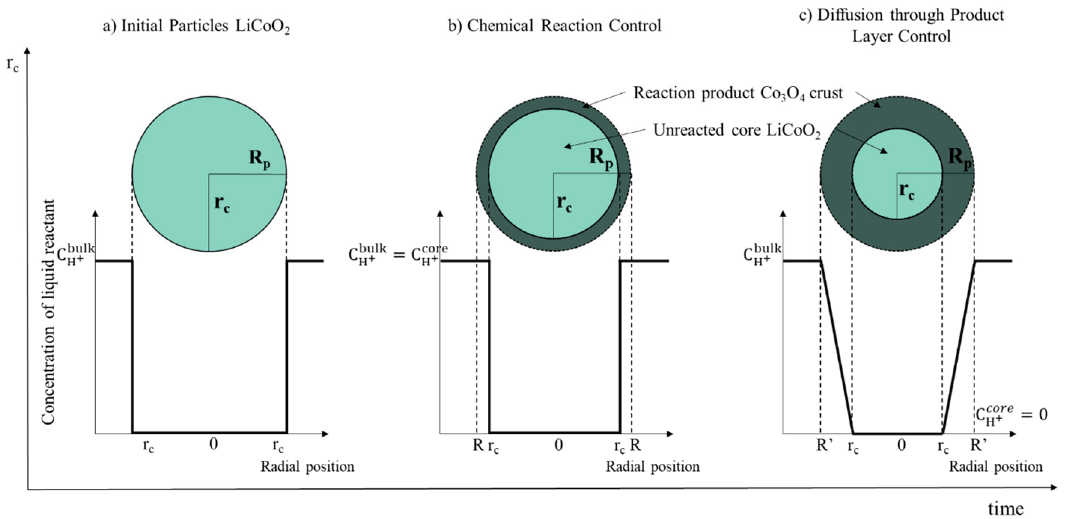
Figure 1. Time transition of the radius core LiCoO 2 particles. ( a ) Initial particles. ( b ) Process rate controlled by the chemical kinetics. ( c ) Process rate controlled by the diffusion through the outer layer.